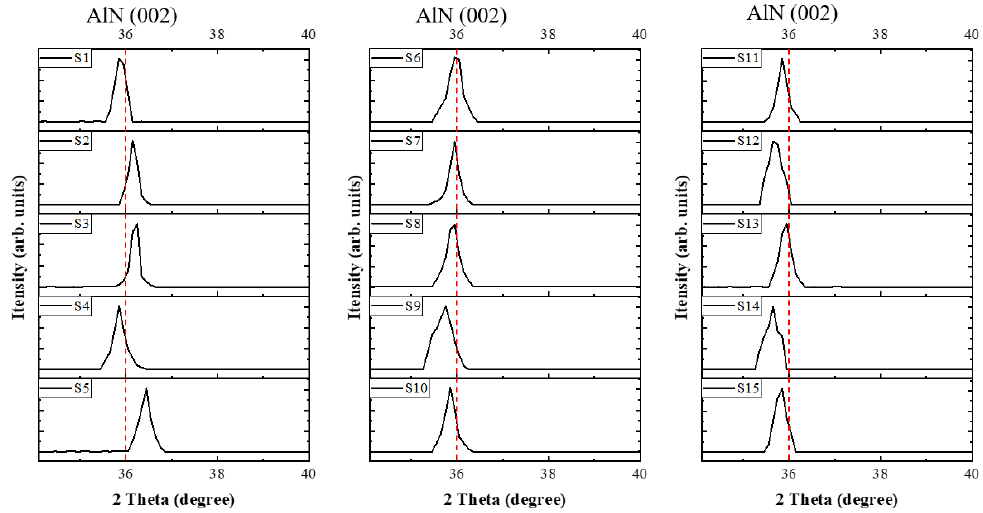
Figure 5. XRD ( θ /2 θ scan) spectra of AlN films (S1–S15) deposited at various DC pulsed parameters of 50–90 V reverse voltage, 100–250 kHz pulse frequency, 80–90% duty cycle as well as N 2 concentration of 100% and flow rate of 60 sccm.